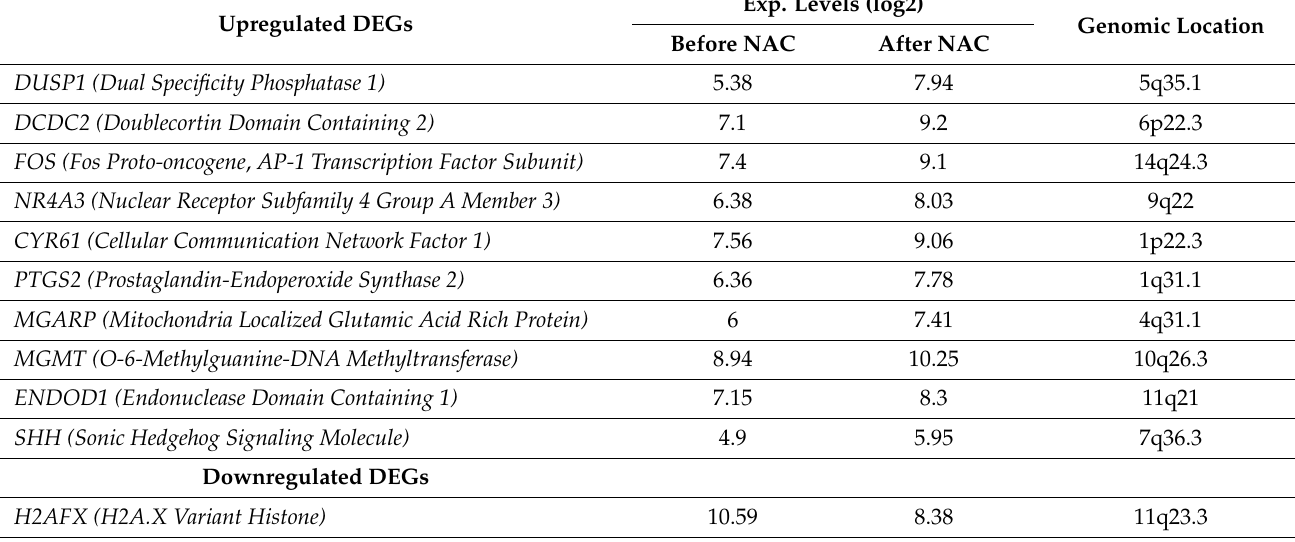
Table 1. Top-10 upregulated and downregulated DEGs in the tumor BC patients before and after NAC chemotherapy.